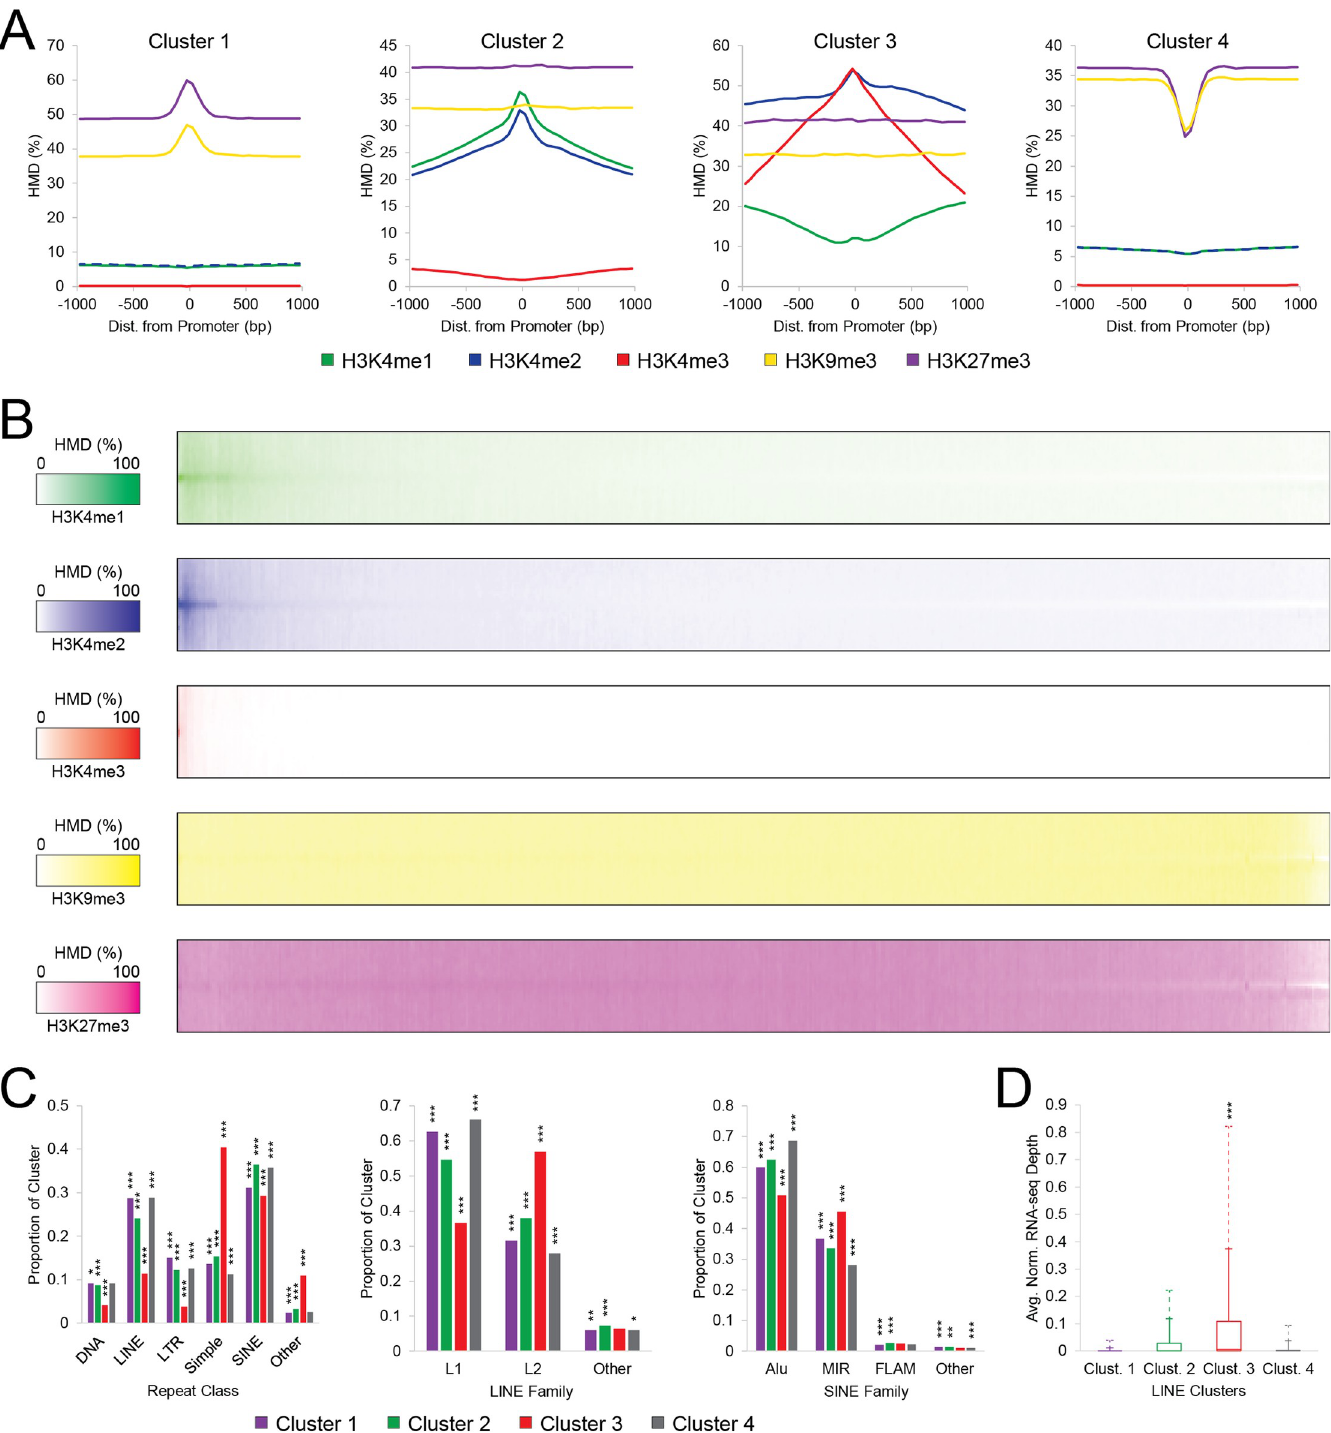
Fig 6. Assessment of histone modifications at promoters of repetitive DNA elements. (A) Mean histone modification densities (HMDs) about promoters for classes of all repetitive elements, as defined by k-means clustering. Corresponding analyses of LINE, SINE, and Simple Repeat elements in S13 Fig. (B) Heatmap of repeat promoters with newly measurable HMD in SmartMap analysis, sorted on first principal component of repetitive elements. (C) Proportion of each cluster comprised by each repeat class or family for all repeats (left), LINE elements (center), and SINE elements (right). All significance tests performed as post-hoc Bonferroni-corrected pairwise 2x2 chi-square tests. (D) Quantile boxplots of average normalized RNA-seq read depth across LINE elements for each LINE cluster. Solid line with marker represents 90 th percentile; dashed line with marker represents 95 th percentile. Significance test shows difference in median by Bonferroni-corrected pairwise Mood’s median tests. Significance markers: � p < 0 . 01 , �� p < 10 −5 , ��� p < 10 −10 . https://doi.org/10.1371/journal.pcbi.1008926.g006 PLOS Computational Biology | https://doi.org/10.1371/journal.pcbi.1008926 April 19,